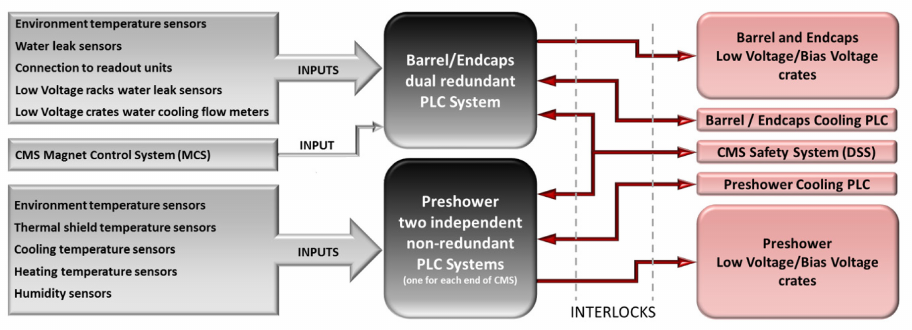
Figure 3. The CMS ECAL Safety Systems